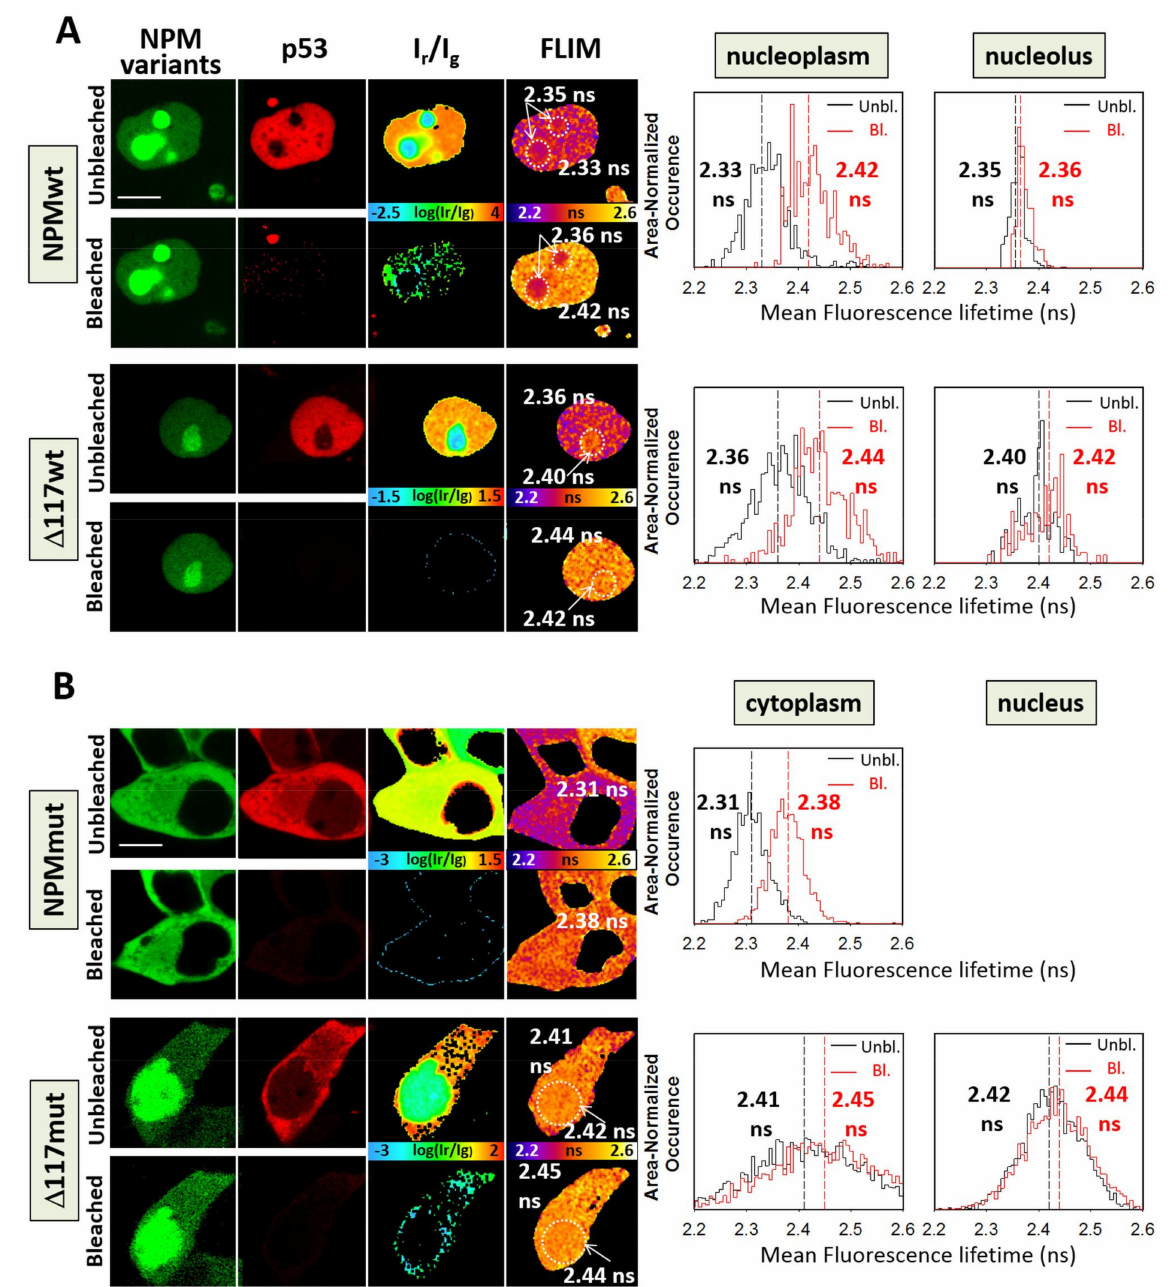
Figure 5. Interaction of R_p53 with eGFP-labeled variants of NPM in live HEK-293T cells examined by FLIM-FRET. ( A ) Interaction of p53 with NPM variants with unmodified C-terminus. Upper two rows—co-expression of R_p53 with G_NPMwt, lower two rows—co-expression of R_p53 with G_ ∆ 117wt; ( B ) interaction of p53 with NPM variants bearing mutation at the C-terminus. Upper two rows—co-expression of R_p53 with NPMmut, lower two rows—co-expression of R_p53 with G_ ∆ 117mut. Columns from left to right represent localization of the green fluorescence I green (NPM variants), red fluorescence I red (R_p53), ratio I red /I green , and fluorescence lifetime maps of eGFP before (row Unbleached) and after (row Bleached) mRFP1 photobleaching. Histograms contain pixel-based lifetime distributions from the nucleolus and nucleoplasm before (black line) and after (red line) the mRFP1 photobleaching. Bar represents 10 µ m, abbreviations can be found in Table 1. Representative results from 3–5 repeated experiments are